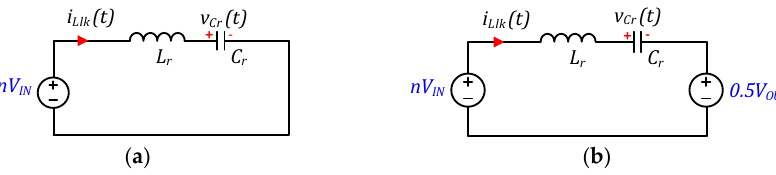
Figure 6. Equivalent circuit of the resonant tank operation during: ( a ) Mode I and ( b ) Mode II.